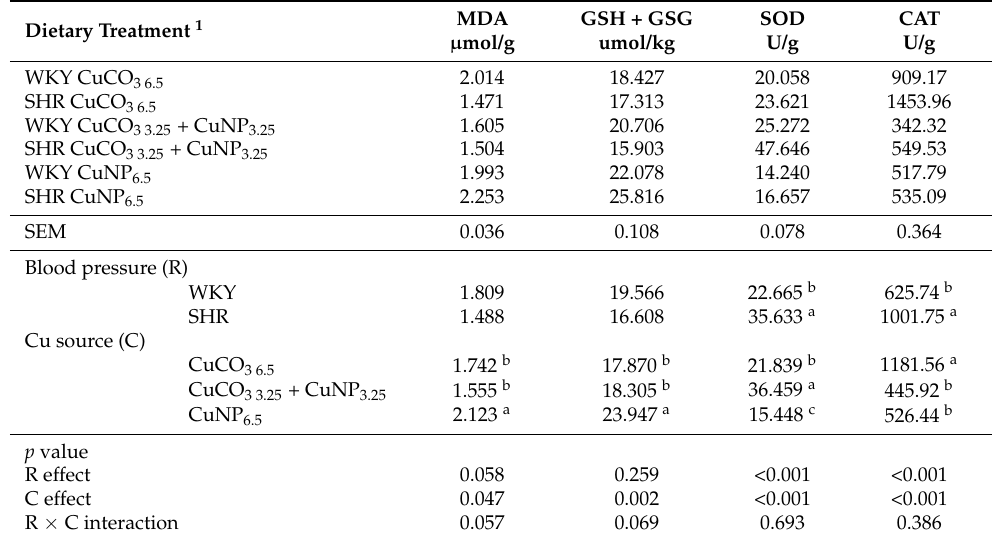
Table 3. Redox status in liver tissue. Dietary Treatment 1